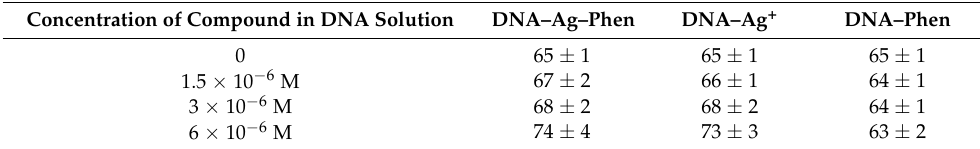
Table 1. Melting temperature T m of DNA in complexes with Ag–Phen, Phen and Ag + in 0.005 M NaNO 3 . Concentration of Compound in DNA